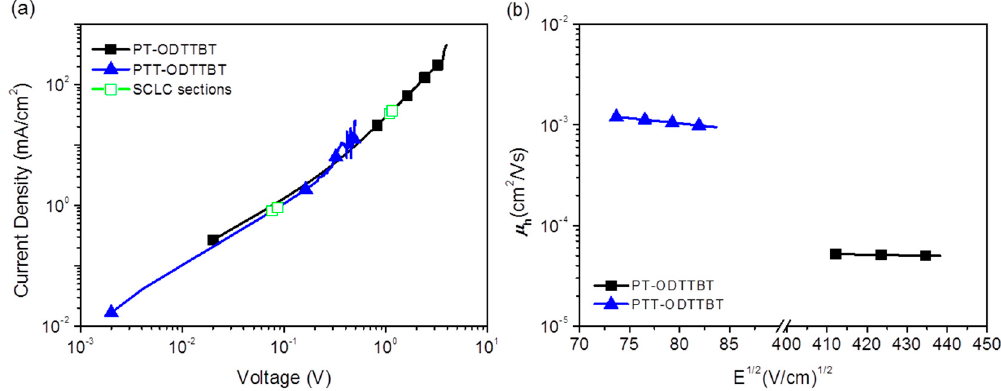
Figure 3. ( a ) J-V characteristics of the hole-only devices and ( b ) field-dependent hole mobilities of polymer:PC 71 BM (1:2 w / w ) blend films calculated for the hole-only devices by fitting J - V curves in the SCLC regime. Table 2. Photovoltaic properties of polymer:PC 71 BM-based OPV devices.